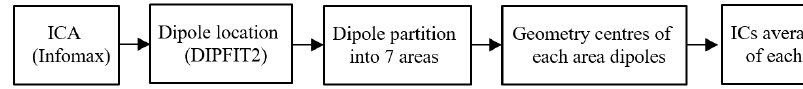
Figure 3. Work-flow of dipole partition processes A multivariate vector autoregressive (MVAR) model has been widely used to analyse neural activity data and brain connectivity (Bressler & Seth, 2011; Friston, Bastos, Oswal, van Wijk, Richter, & Litvak, 2014; Lin et al., 2016) and is the commonest operational model of Granger causality (Granger, 1969). In this study, we adopted the multivariate Granger causality (MVGC) toolbox (Barnett & Seth, 2014) to implement the MVAR model to investigate brain activity networks in a time domain. Compared with other tools (Delorme & Makeig, 2004), MVGC improves computational efficiency and